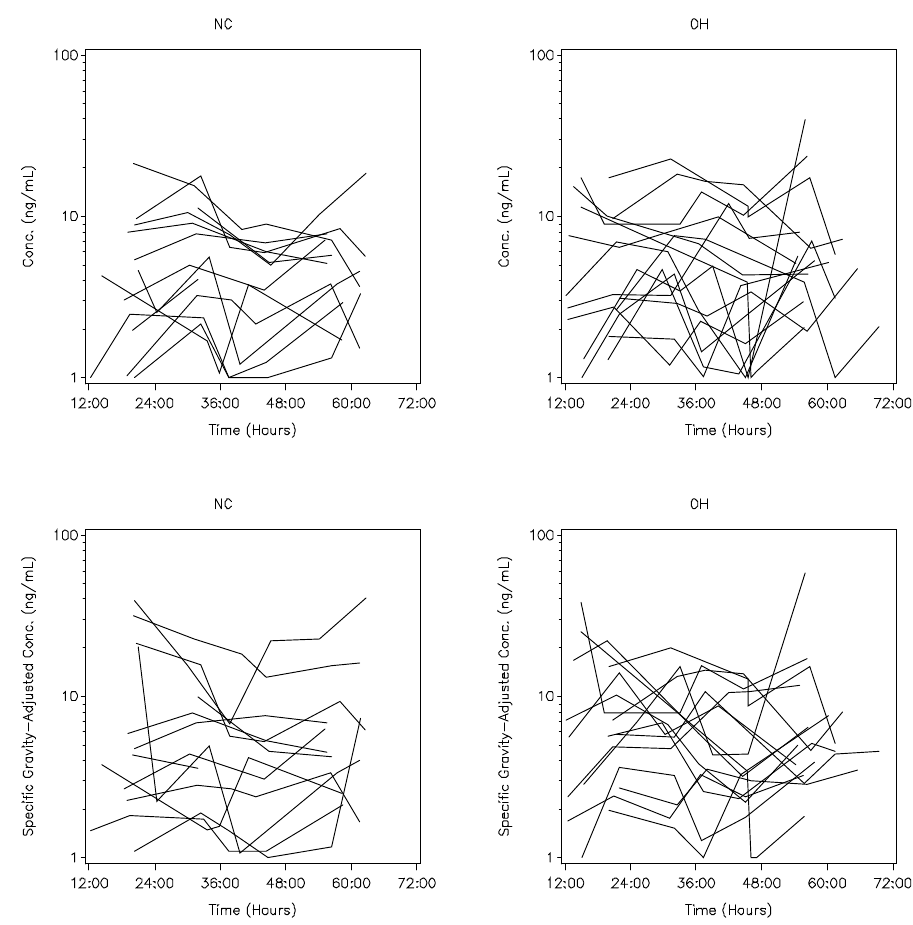
Figure S-1. Concentration versus time plots for urinary TCPy measurements among CTEPP-NC and CTEPP-OH participants reporting a recent pesticide application. Urines in panels A and B are without adjustment. Urines in panels C and D are adjusted by specific gravity. Note that not all voids within the 48 hour period were